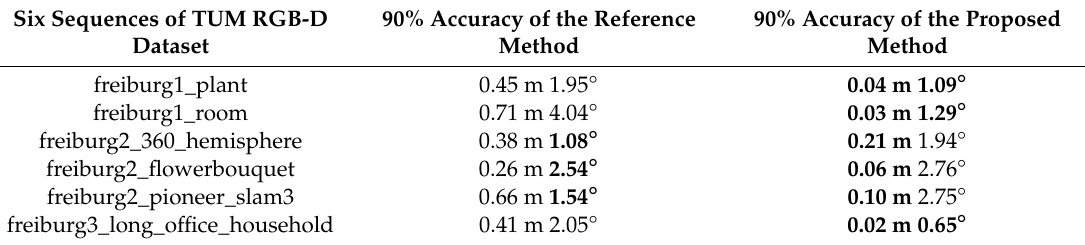
Table 5. The cumulative pose errors of the reference method and the proposed method in six sequences. Each term contains a mean error and a median error. The unit of position error is meter and the unit of attitude error is degree. The numbers in bold indicate that these terms are better than those of the other